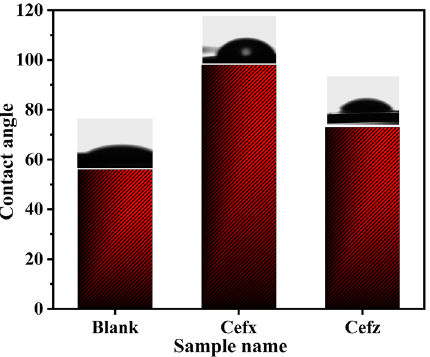
Figure 11. Contact angle measurements of 0.1 M NaOH solutions on Al substrates in the absence and presence of 300 ppm of Cefx and Cefz.